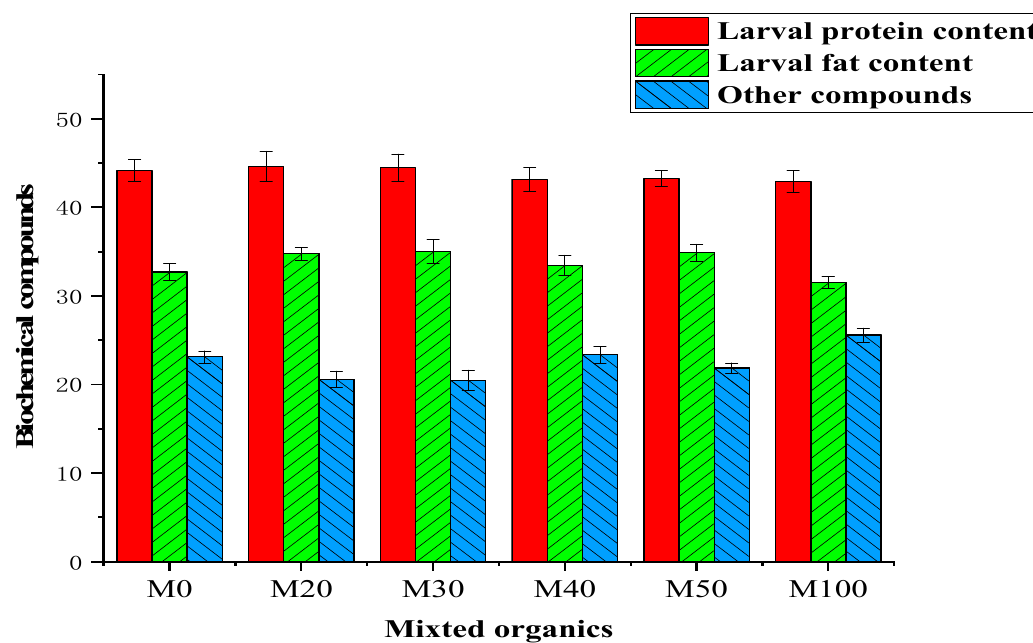
Figure 1. Nutritional profiles (%) of BSFL biomasses reared using various mixed organics ( n = 3).